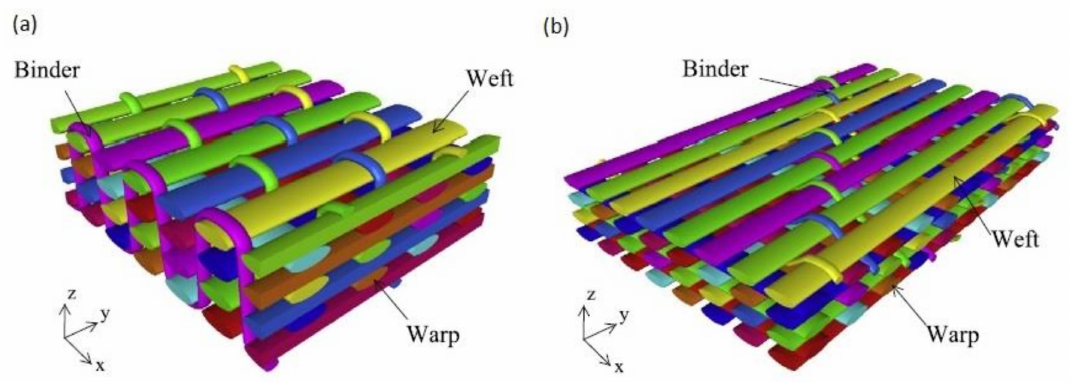
Figure 24. Two types of composite stitching: ( a ) through-the-thickness stitching 1-by-1 orthogonal weave W-1 and ( b ) through-the-thickness angle interlock weave W-3 (right) [160].